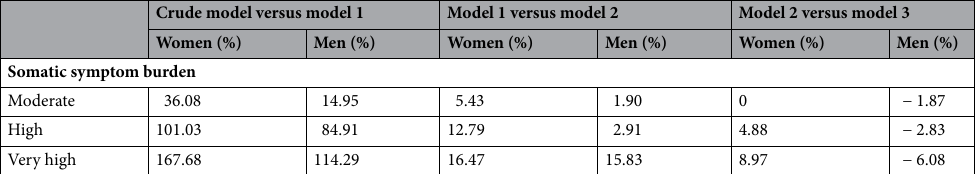
Table 3. Magnitude of Confounding (%) in the stepwise adjusted cox regression models estimating the association between somatic symptom burden and all-cause mortality in women (n = 5679) and men (n = 5861) in Table